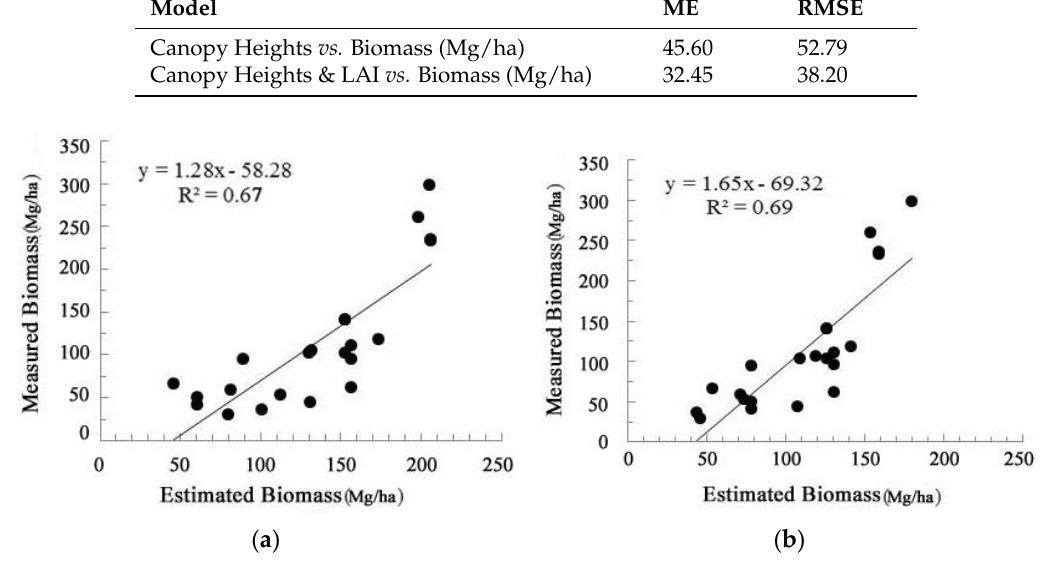
Figure 7. Biomass validation results based on unused field-measured data. ( a ) Heights vs. biomass; and ( b ) heights and LAIs vs. biomass ( n = 21).